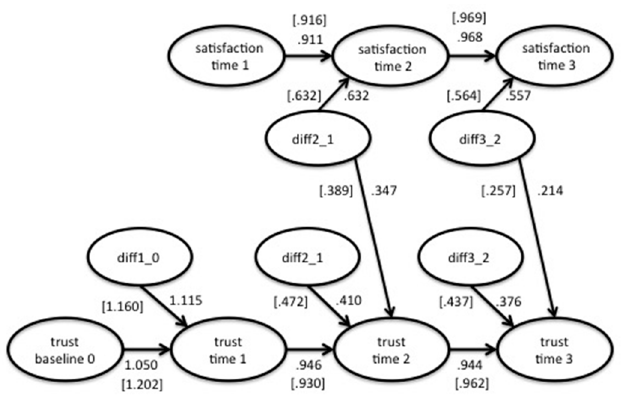
Figure 3. Latent change in satisfaction influencing trust. Standardized parameter estimates for affective trust are not bracketed; those for cognitive trust are given in brackets. All estimates are significant p < 0.01. For clarity, the measurement model and indicator specific latent variables are not presented.